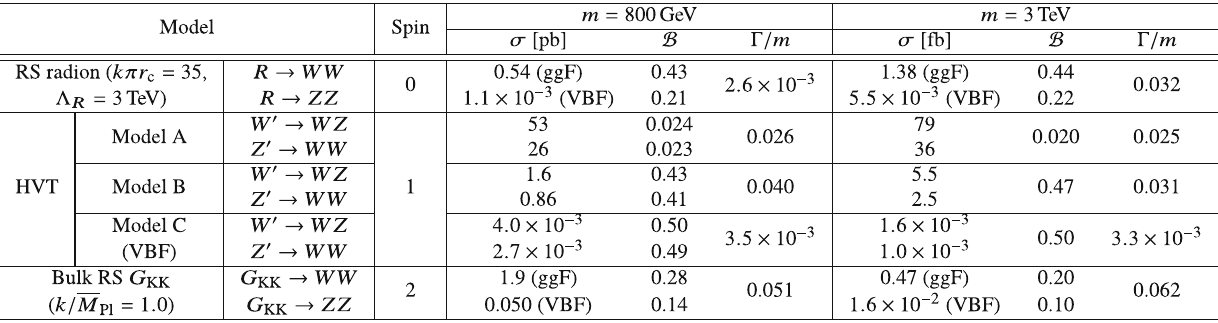
Table 1 List of benchmark signal models. Predictions of cross-section σ , branching ratio B into WW , W Z , or Z Z , and intrinsic width divided by the resonance mass (cid:12)/ m , for the given hypothetical new particle at m = 800GeV and 3TeV are